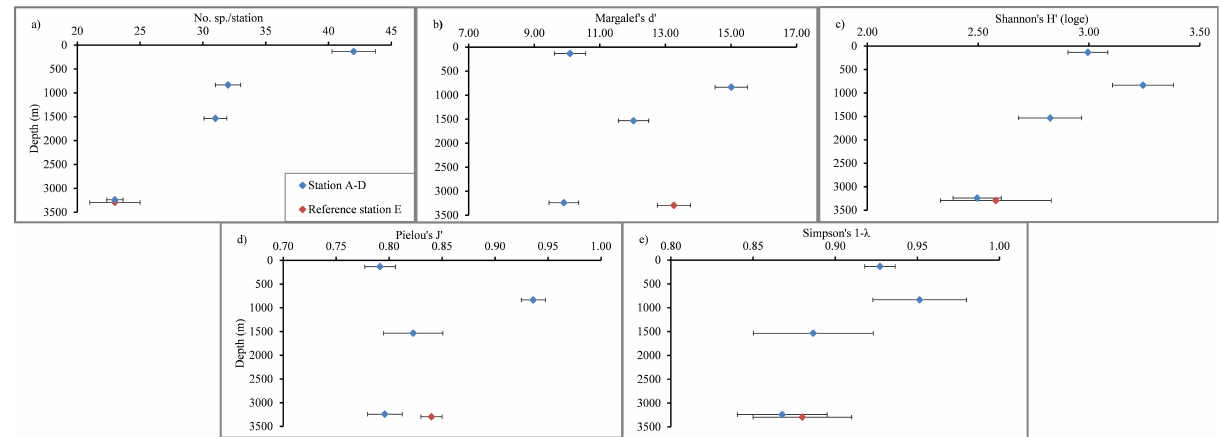
Fig. 3. Diversity of the macrobenthic polychaetes along the north transect; (a) number of species/station, (b) Margalef’s richness ( d 0 ), (c) Shannon’s diversity ( H 0 loge), (d) Pielou’s evenness ( J 0 ), (e) Simpson’s dominance (1- λ